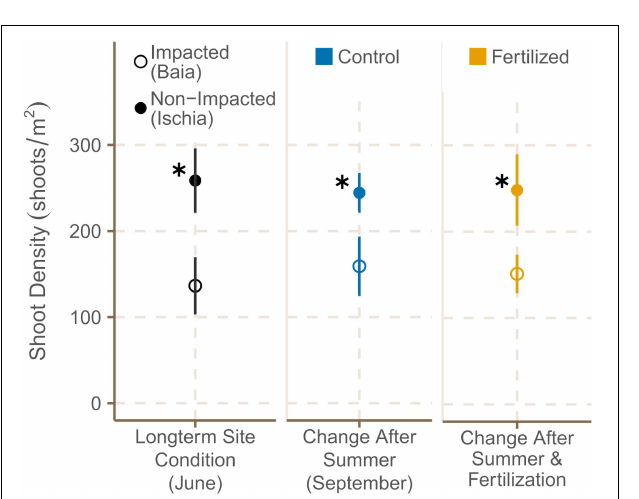
FIGURE 3 | Shoot density [shoots m 2 ] (mean ± SE) of fertilized and control plots in June 2019 and September 2019. (cid:81) Shows significant differences between impacted (Baia) and non- impacted (Ischia) areas.